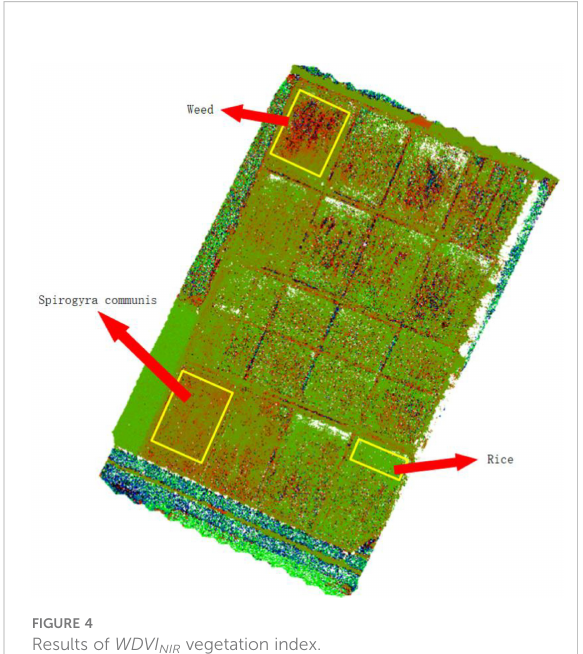
FIGURE 4 Results of WDVI NIR vegetation index.